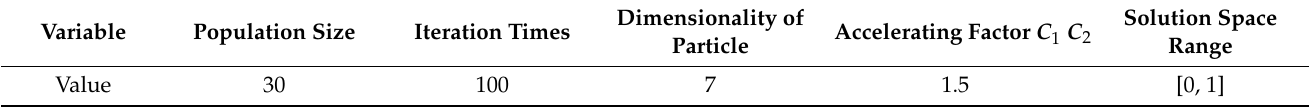
Table 7. Initial value of the